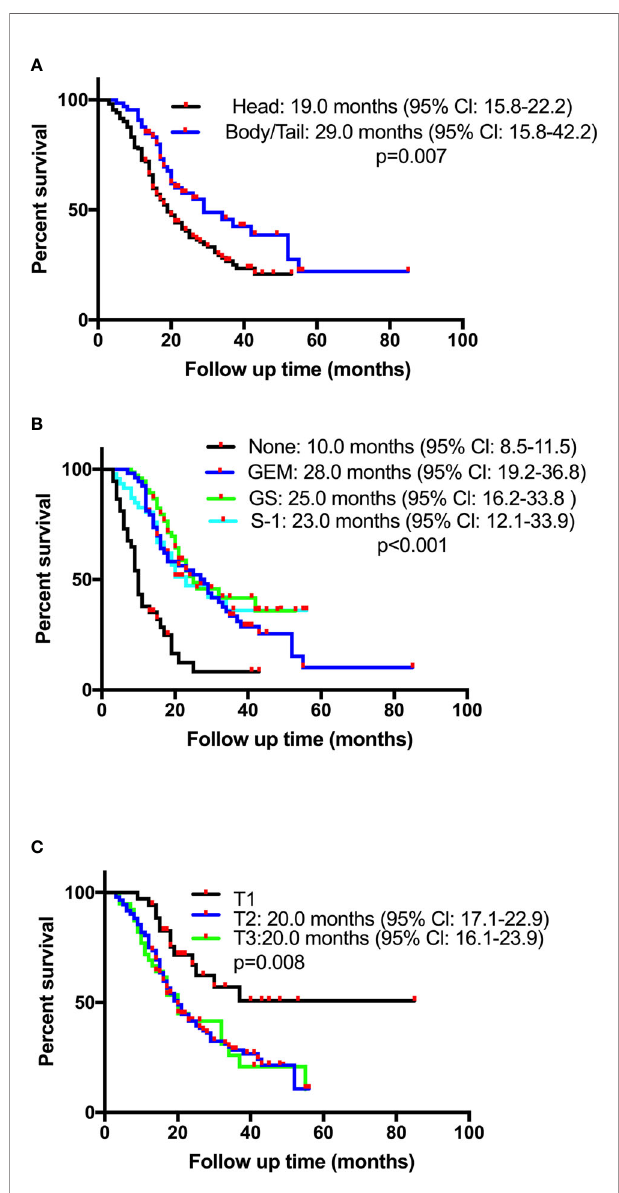
FIGURE 1 | Kaplan-Meier overallsurvival (OS)curves in patients with resectable pancreaticadenocarcinoma whounderwentsurgeryand had lymph node metastasis or R1 resection based on (A) tumorlocation, (B) chemotherapy,or (C) pathological T stage. GEM,gemcitabine monotherapy; GS, gemcitabine plus oral fl uoropyrimidine combination